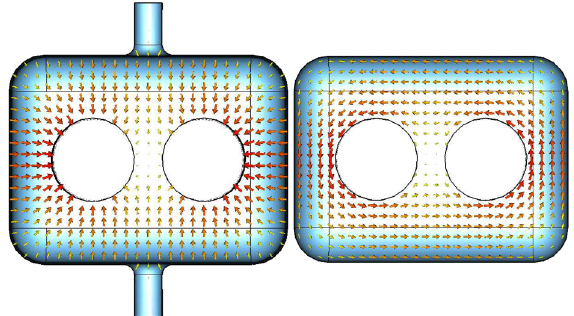
FIG. 5. Electric field (left) on the midplane and magnetic field (right) on the top plane for the fundamental accelerating mode.